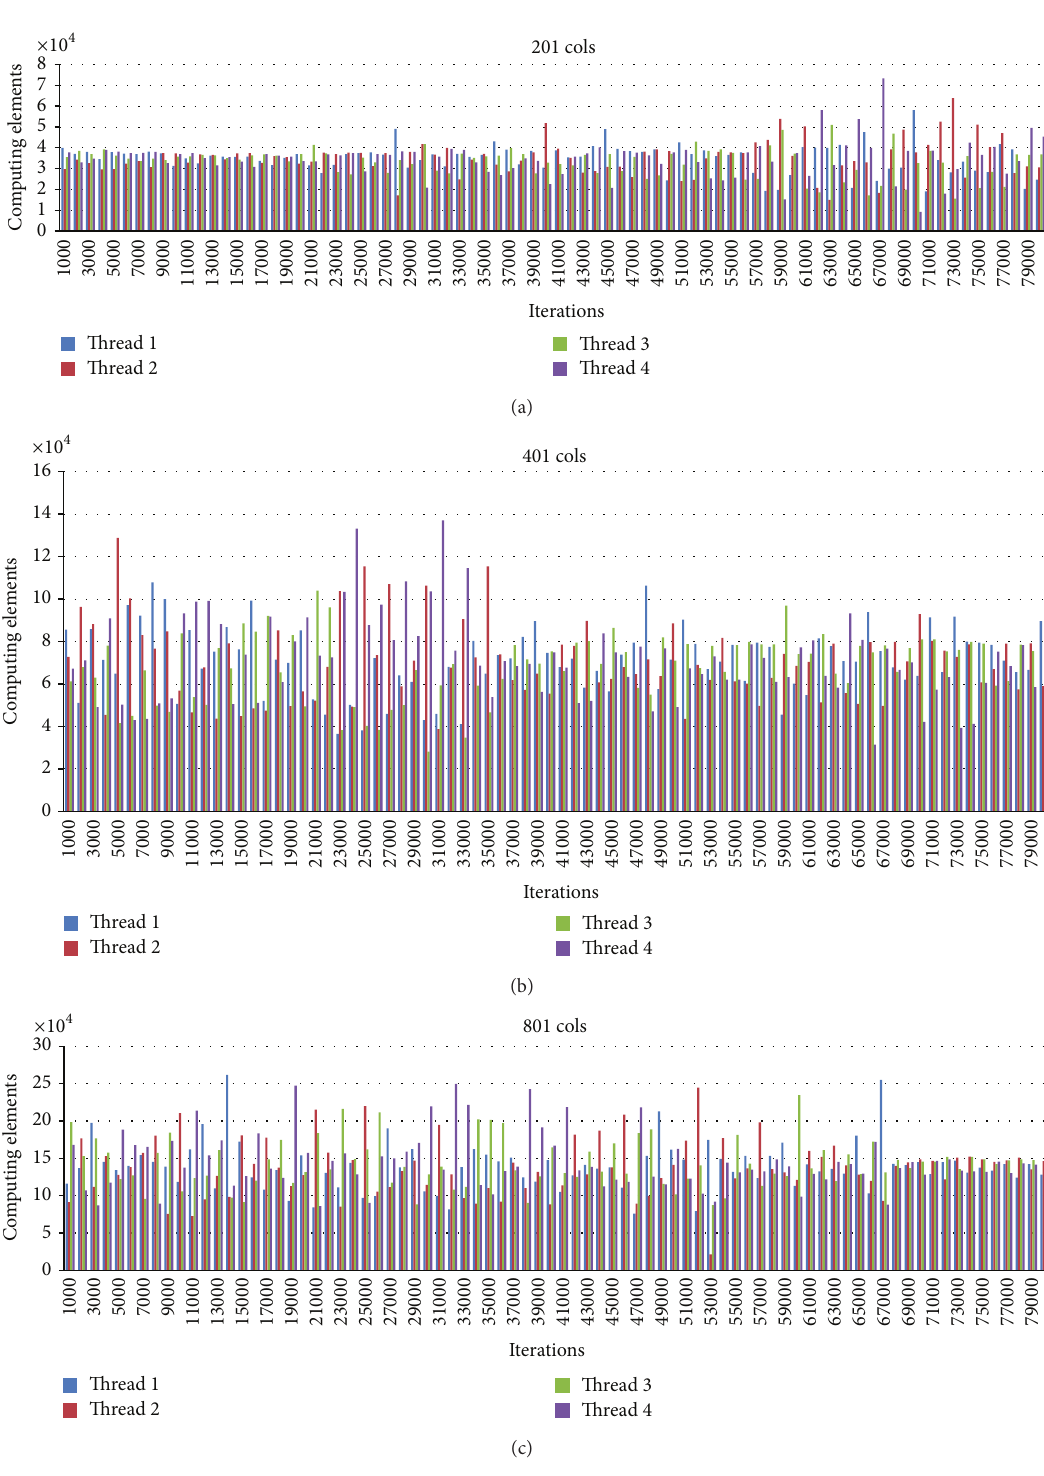
the concentration array is divided with overlapped rows [9]. The synchronization is needed between iterations before going to the next iteration. The nonblocking communication may be considered to hide this latency